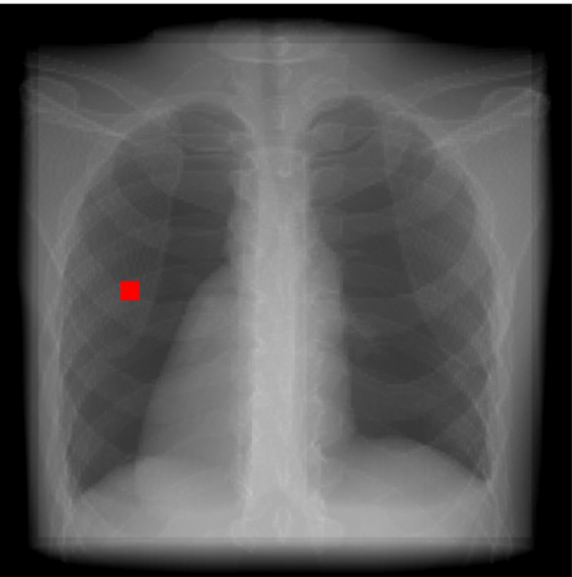
Figure 6. Relative position of the tumor (the red cube) in the fluoroscopy image of the phantom.